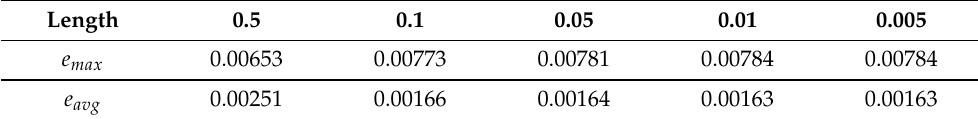
Table 3. Absolute errors with different sample point interval